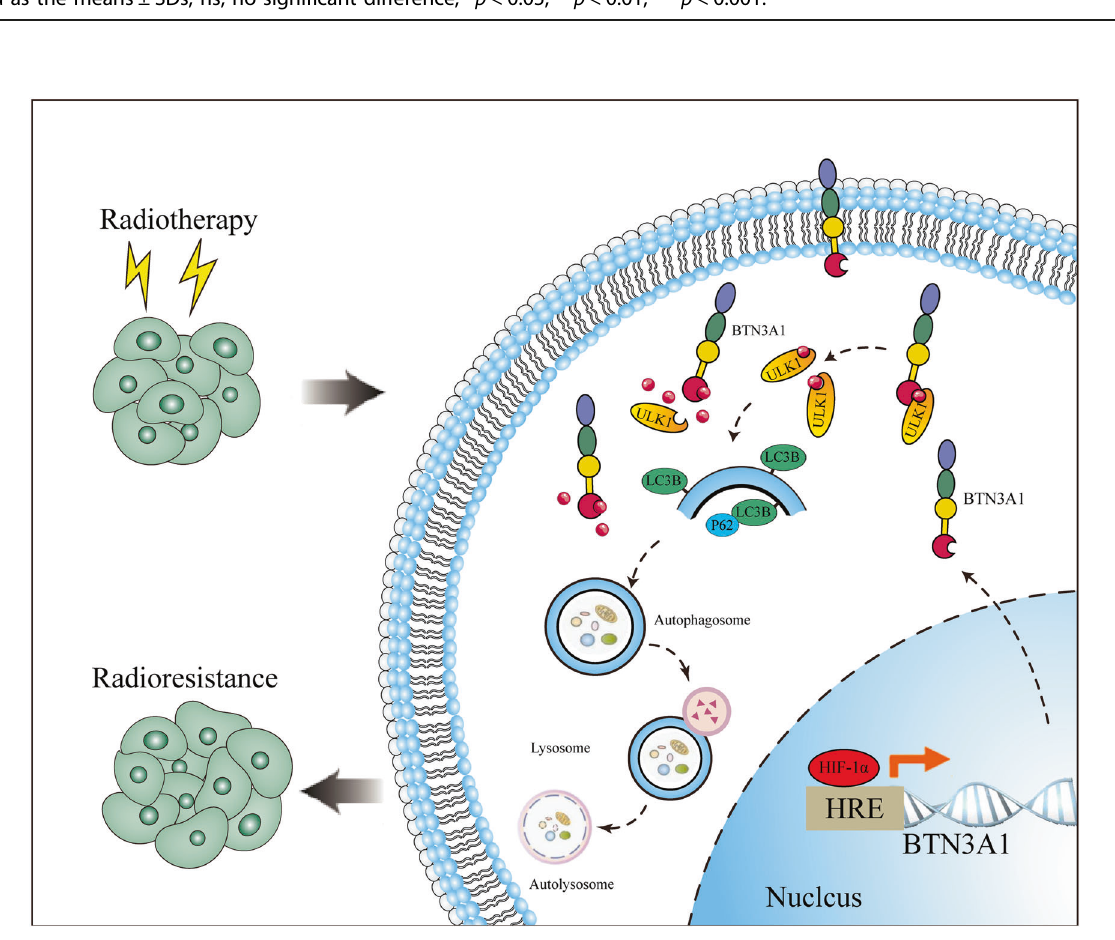
Fig. 7 Radiation increases BTN3A1 expression through a process mediated by HIF-1 α . A , B KYSE150 and ECA109 cells were treated with or without IR (8 Gy). Then cells were collected at different time points and immunoblotted with antibodies against BTN3A1, HIF-1 α and GAPDH. C Cells were treated with 2.5 μ M 2-ME (HIF-1 α inhibitor), irradiated with 8 Gy X-ray, and collected 24 h later. Lysates were immunoblotted with antibodies against BTN3A1, HIF-1 α and GAPDH. D Cells were transfected with HIF-1 α shRNA lentivirus and irradiated with 8 Gy X-ray. After 24 h, cells were lysed and immunoblotted with antibodies against BTN3A1 and HIF-1 α . E , F KYSE150 and ECA109 cells were exposed to 8 Gy radiation. After 24 h, the expression of BTN3A1 and HIF-1 α was examined using IF staining. Scale bar = 100 μ m. G Schematic of the BTN3A1 promoter. The predicted HIF-1 α binding sites were marked as HRE-1, 2, 3, 4, and 5. H Binding of HIF-1 α to the BTN3A1 promoter region in vitro was assessed using ChIP with anti- HIF-1 α or anti-IgG antibodies in KYSE150 cells. I Input DNA puri fi ed by ChIP were measured using qRT-PCR. J , K Luciferase reporter assays using the BTN3A1 promoter in KYSE150 cells. Cells were co-transfected with a series of BTN3A1 mutant promoter plasmids and HIF-1 α overexpression plasmids or the control plasmids. Luciferase activities were measured 48 h later. The data are